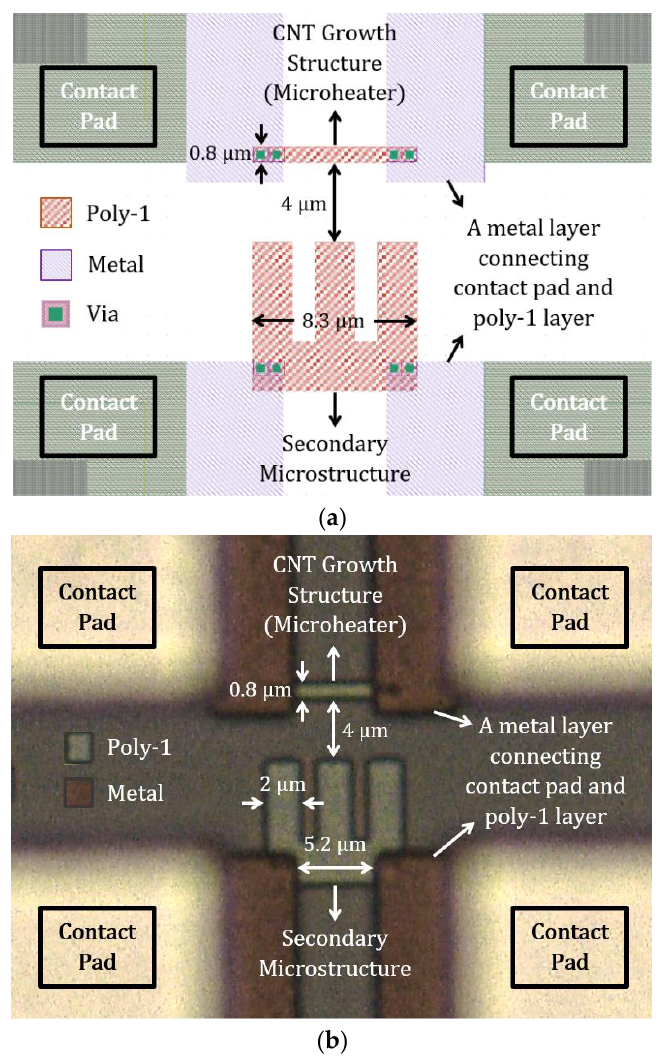
Figure 11. Poly-1 CNT growth structures in AMS 350 nm process: ( a ) layout design and ( b ) optical micrograph.